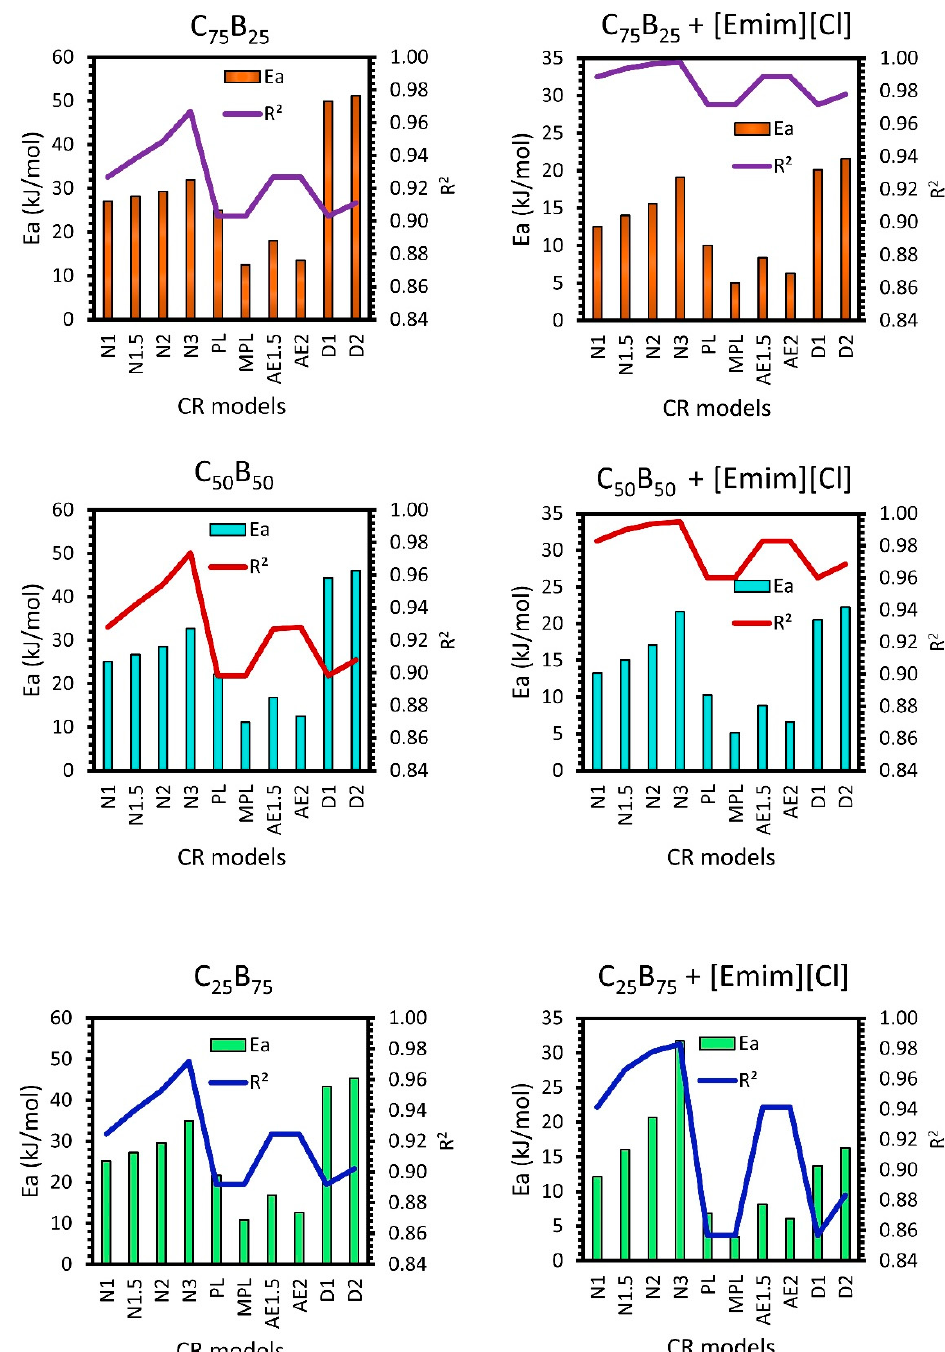
Figure 2. Ea and R 2 values for untreated and IL treated blends using ten CR models. Table 3. Thermodynamic parameters calculated for untreated and IL treated blends.